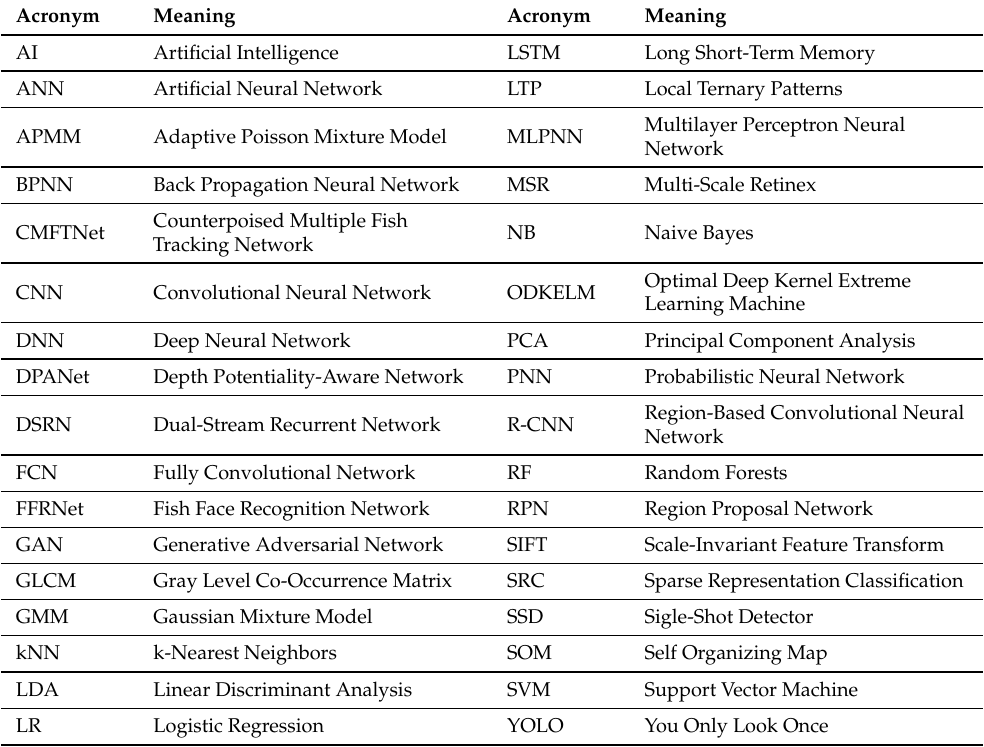
Table 2. Acronyms used in this